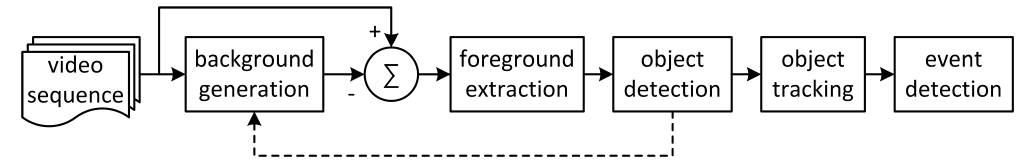
Figure 1. Video content analytics algorithm based on background subtraction.